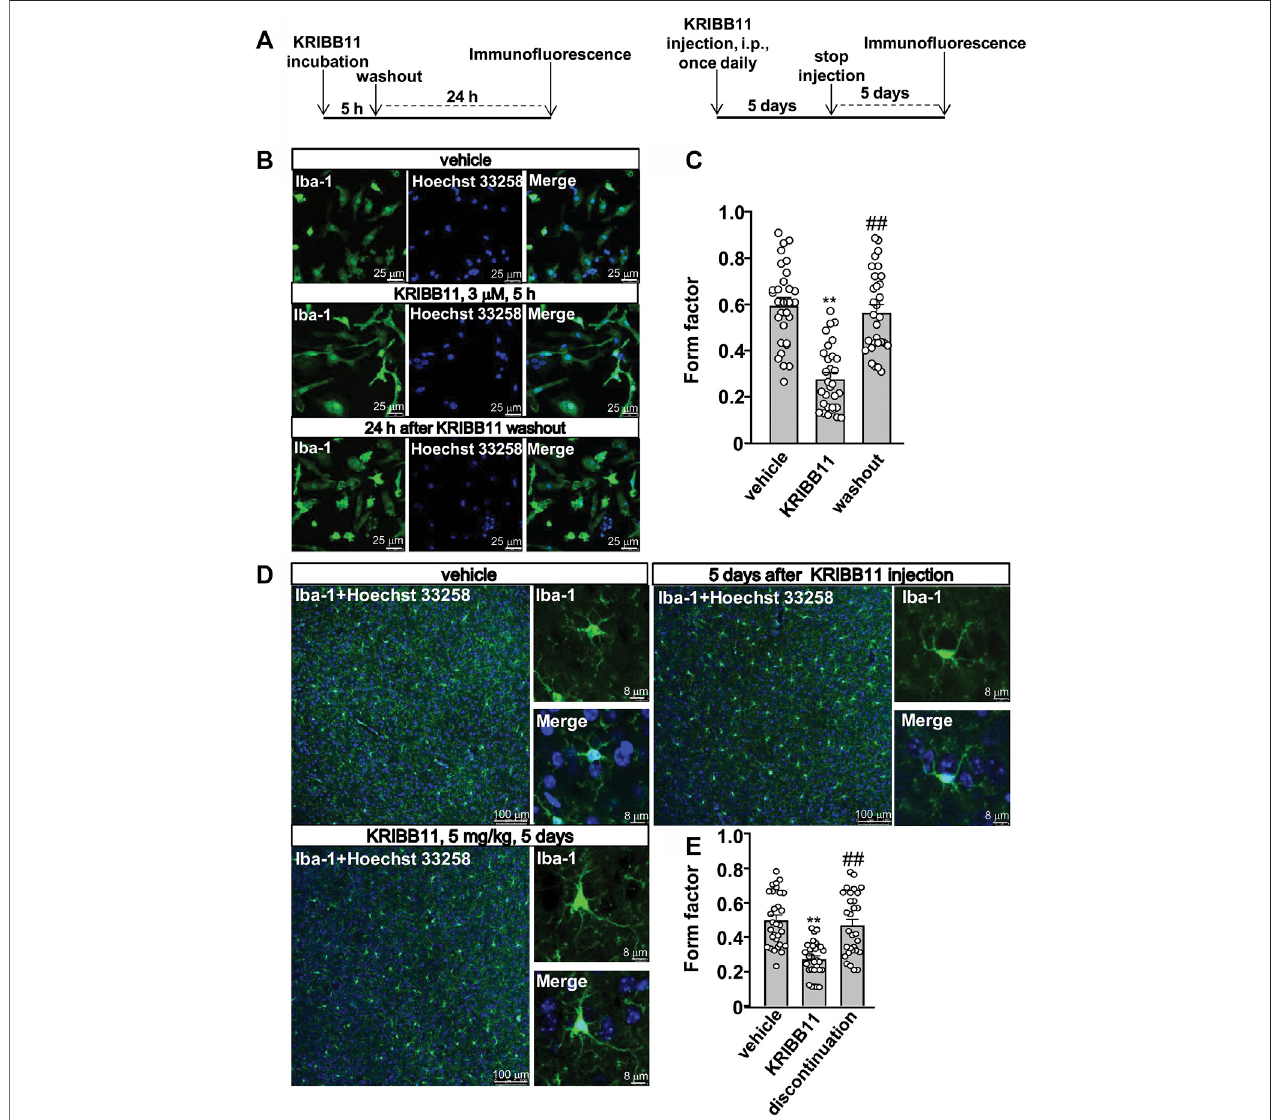
FIGURE2| ReversibleeffectsofKRIBB11onmicroglialprocessatconditions invitro and invivo . (A) Aschematicdiagramshowingthetimelinefortheevaluationof the reversal effect of KRIBB11 treatment on microglial process elongation at conditions in vitro (left) and in vivo (right). (B,C) Representative images (B) and quantitative analysis (C) showed the effect of KRIBB11 treatment (3 μ M, 5 h) and washout on primary cultured microglial process (** p < 0.01 vs. vehicle, ## p < 0.01 vs. KRIBB11). (D,E) Representative images (D) and quantitative analysis (E) showed the changes in microglial process in the dorsolateral prefrontal cortex before, during, and 5 days after KRIBB11 treatment (5 mg/kg; ** p < 0.01 vs. vehicle, ## p < 0.01 vs. KRIBB11). For cell shape investigation at conditions in vitro and in vivo , 30 cells per condition were analyzed in three independent experiments. Scale bars for in vitro analysis is 25 μ m, and scale bars for in vivo analysis in the low and high magni fi cation images are 100 and 8 μ m, respectively. Data are shown as mean ±